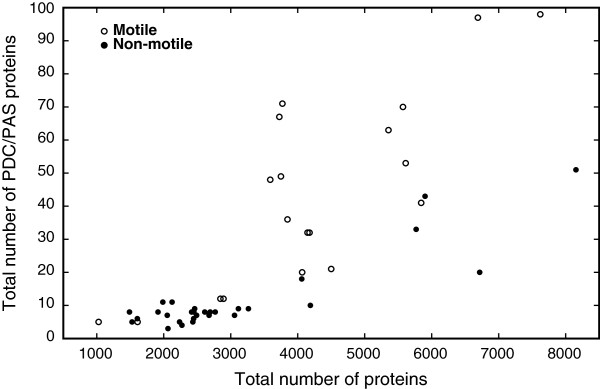
Correlation between the total protein numbers and the numbers of PDC/PAS proteins across 48 bacterial genomes. The correlation is significant either based on all 48 genomes or based on only 43 genomes (excluding 5 over-representing Staphylococcus genomes): for 48 genomes, Pearson’s correlation coefficient r = 0.77 (p < 0.0001) and Spearman’s rank correlation ρ = 0.83 (p < 0.0001); for 43 genomes, Pearson’s correlation coefficient r = 0.76 (p < 0.0001) and Spearman’s rank correlation ρ = 0.82 (p < 0.0001). Bacterial species were classified as motile or non-motile (see Table 1), and they were plotted with open and closed circles, respectively.